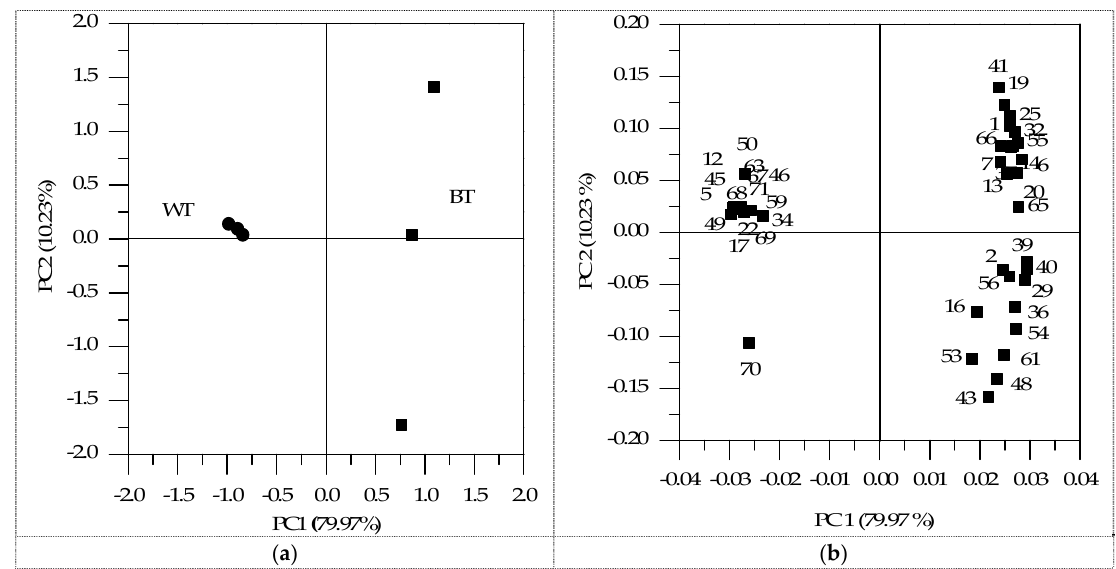
Figure 4. Principle component analysis (PCA) score plot: ( a ) BT and WT samples; ( b ) the compounds detected in both samples with a significant difference and those detected in BT, but not in WT, or vice versa (numbers correspond to Table 1). Table 2. Aroma description and threshold values of the major volatile compounds in BT and WT with a significant difference and the compounds that can be detected in BT, but not in WT, or vice versa . Aroma Threshold No. a Compound Description Values 2-Butanol 1700 ppb b — A penetrating, wine-like, 360 ppb to 3.3 ppm c disagreeable odor c